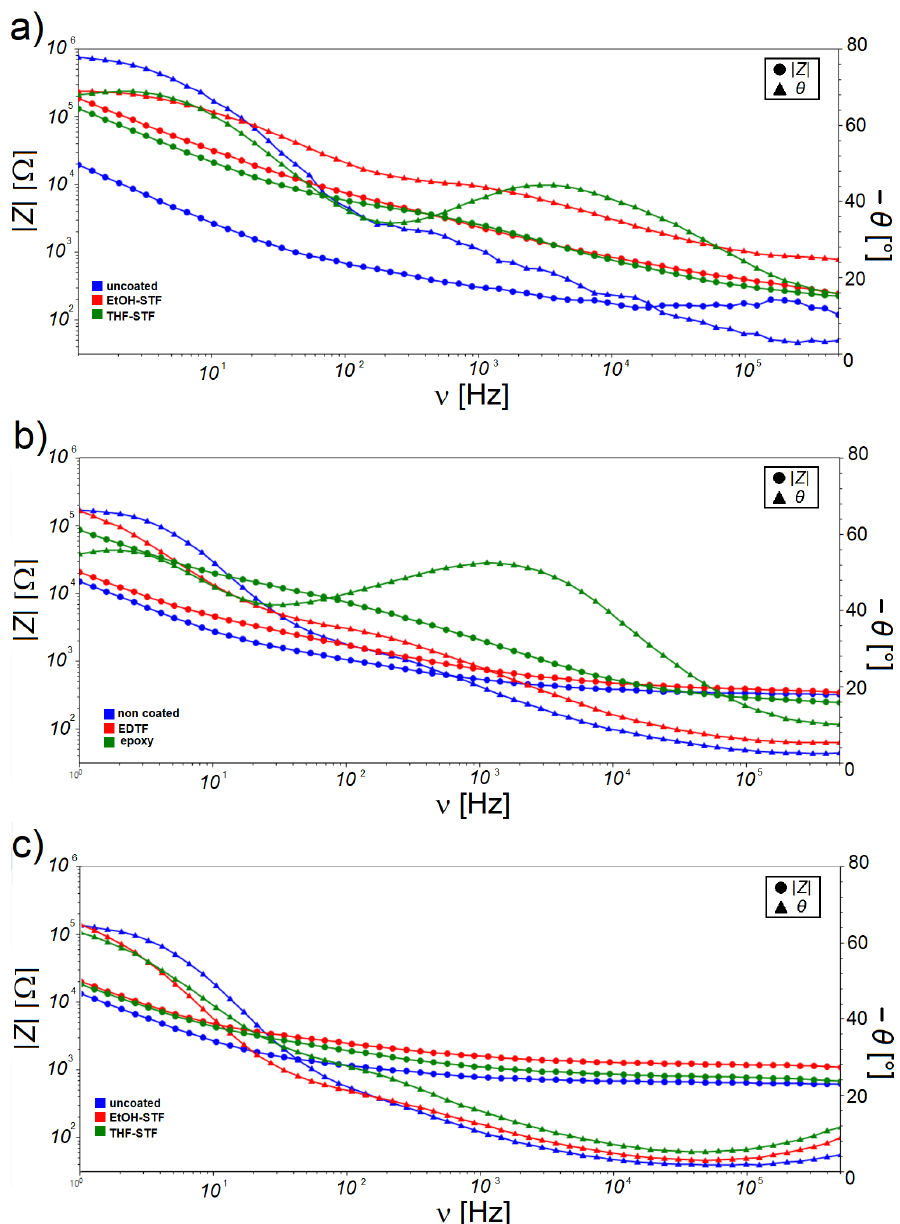
Figure A1. Bode plots of the assembled device exposed to different solvents: ( a ) water, ( b ) ethanol, and ( c ) THF. Each graph contains the measurements for the three working electrodes: uncoated stainless steel (blue), coated with ethanol-susceptible thin film (red), and coated with THF-susceptible thin film